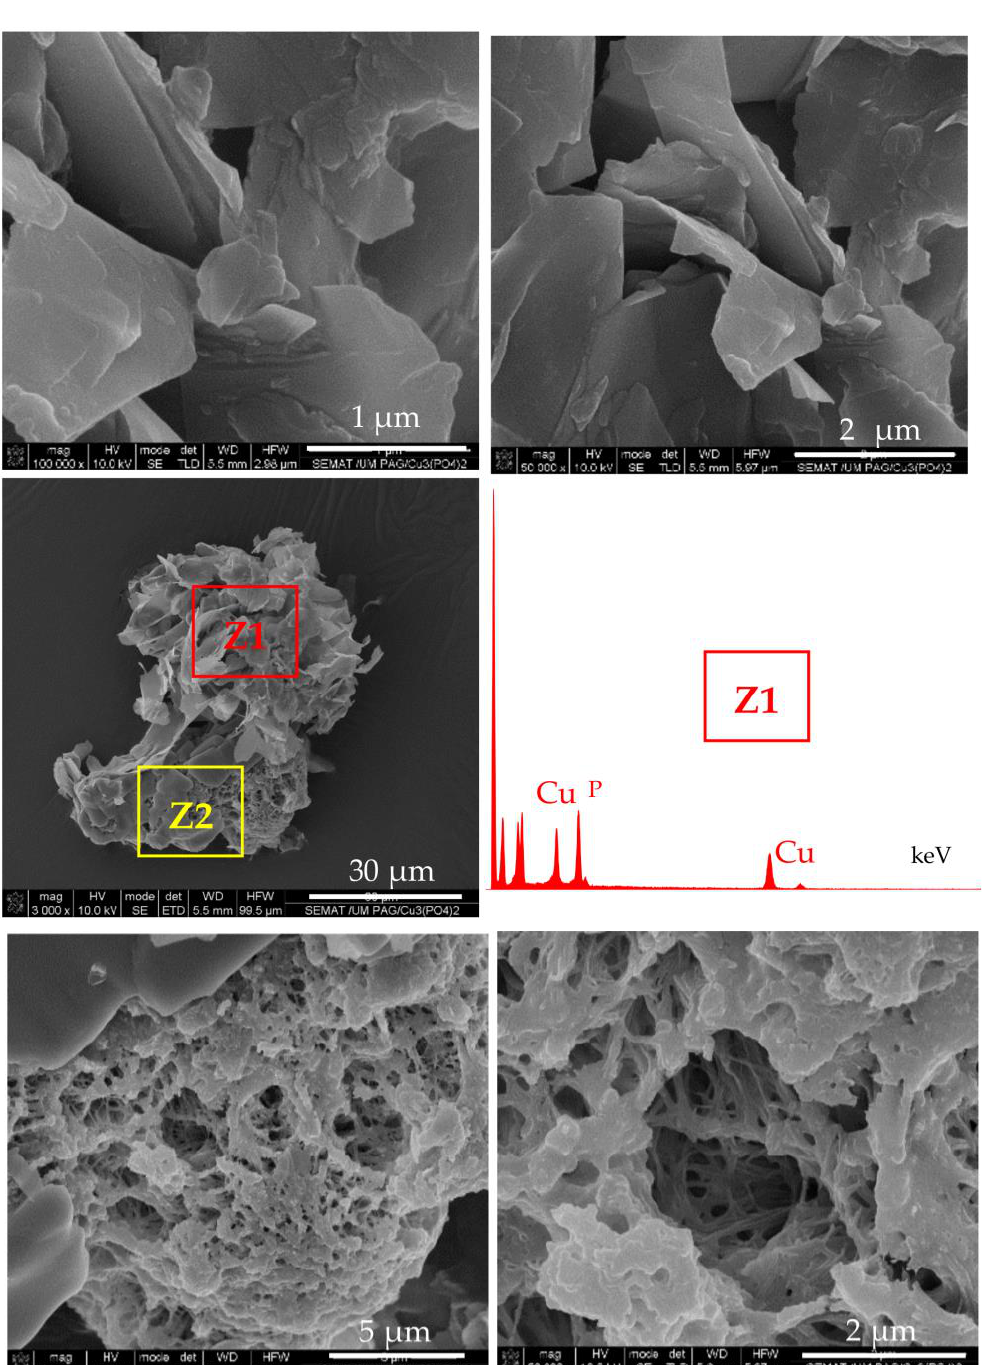
Figure 4. SEM images of micro and nanostructures obtained after incubation of PA6 MP with CuSO 4 .5H 2 O in PBS, in the absence of enzymes. Central image: overall appearance; Top images: close view of the petal-shaped platelets originating from the inorganic component (Z1); Bottom images: close view of the porous scaffold-like morphology originating from the PA6 MP component (Z2). The EDX data of Z1 localization is presented as inset.